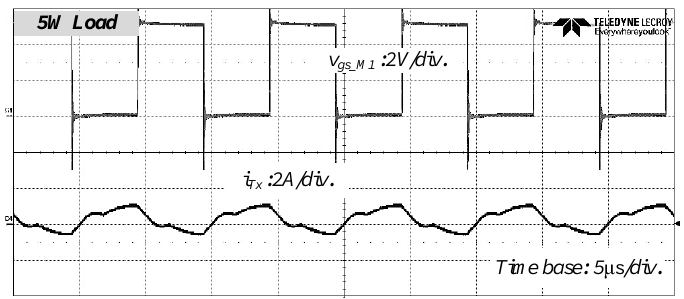
Figure 14. Experimental waveforms in the over coupling condition with the LC resonance operation.